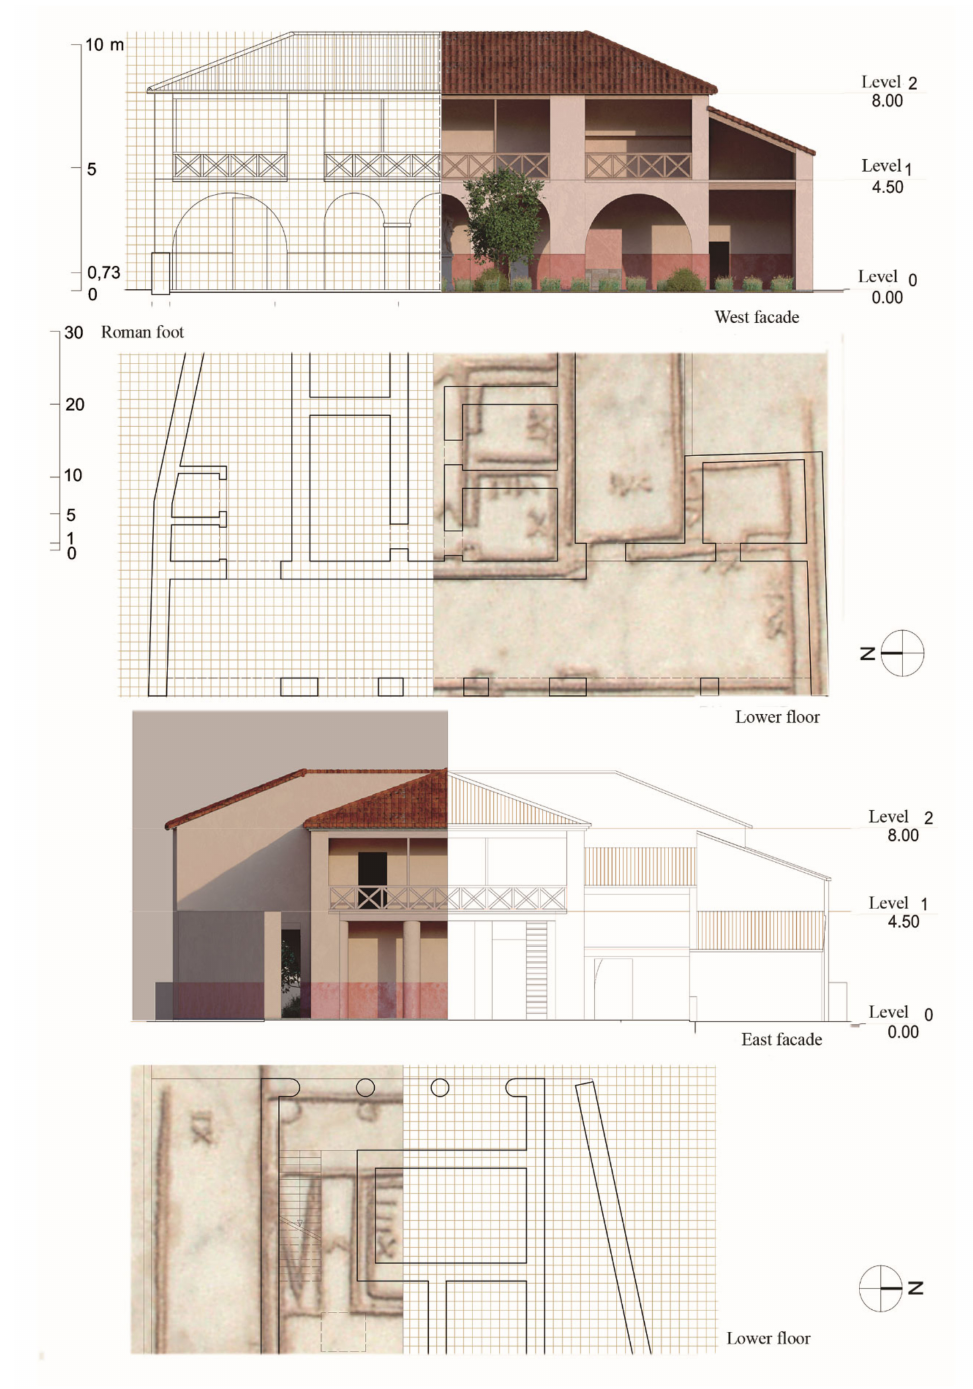
Figure 4. Reconstructive hypothesis of the Aedificium custodiae ’s East and West façades referred to the related